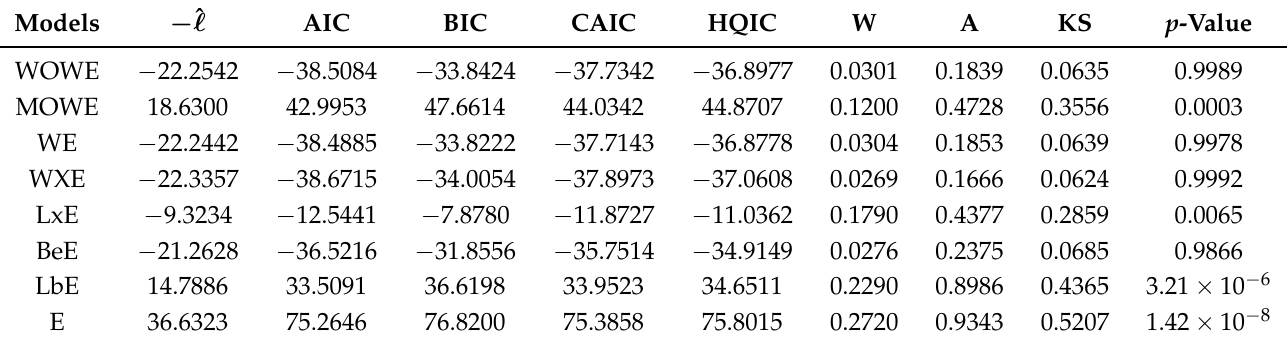
Table 8. Fit measures for the daily precipitation